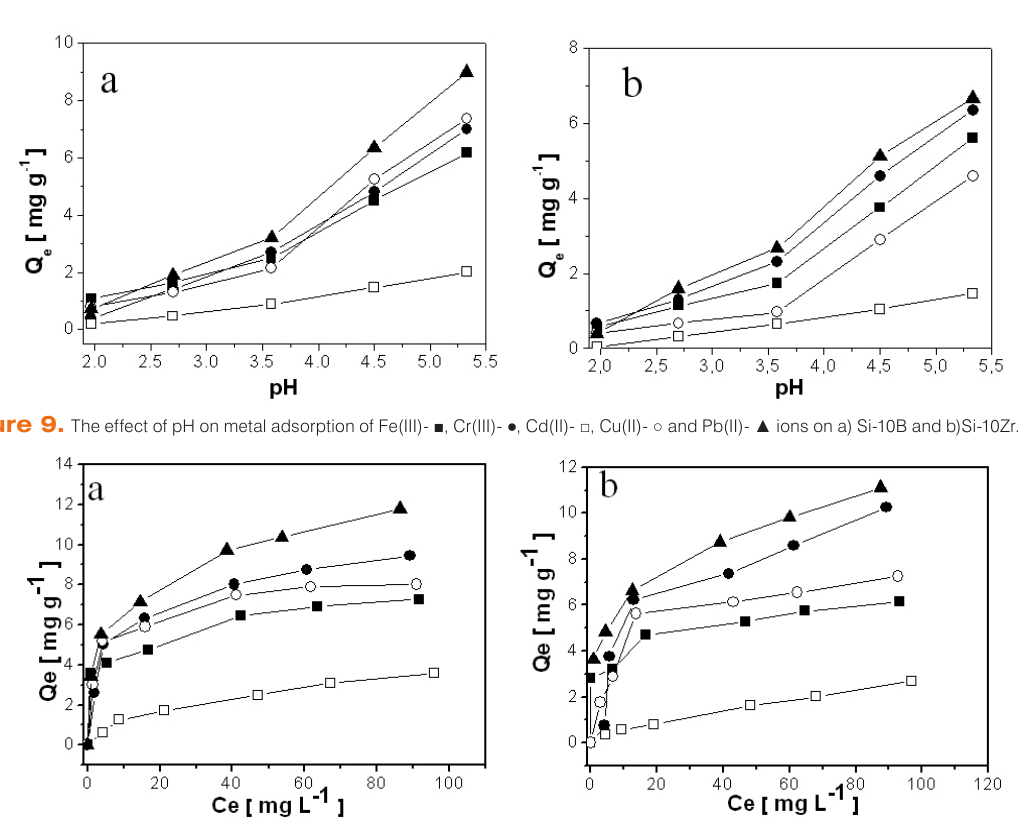
Figure 10. Adsorption isotherms for multi-component solutions of Fe(III)- ■ , Cr(III)- ● , Cd(II)- □ , Cu(II)- ○ and Pb(II)- ▲ ions on a)Si-10B and